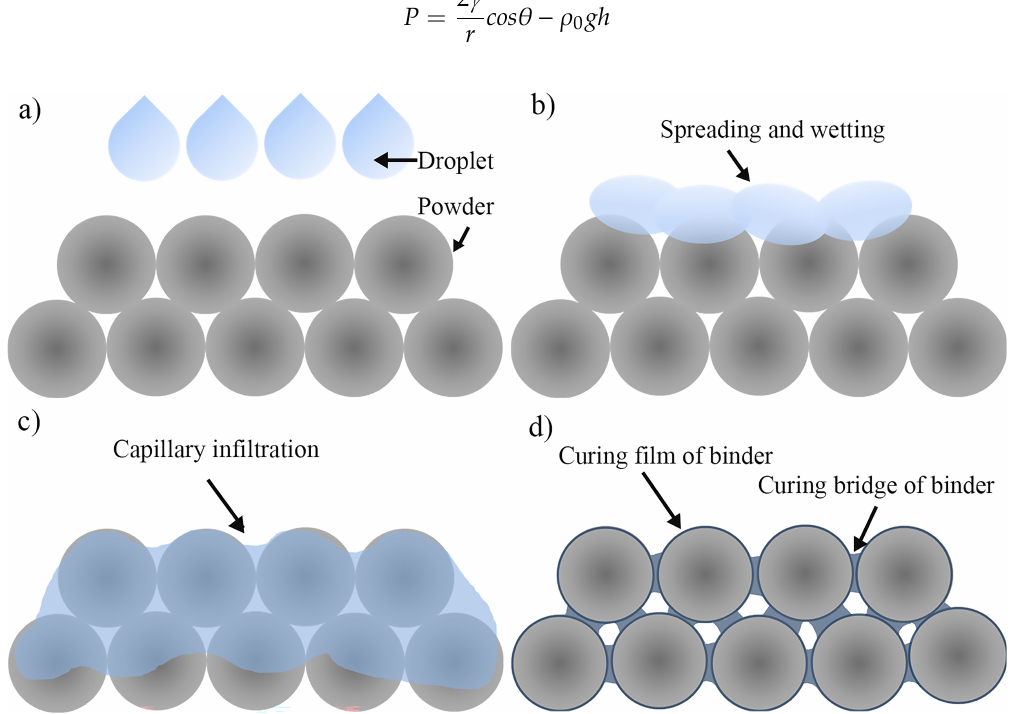
Figure 2. Principle of capillary infiltration forming of polymer binder, ( a ) binder droplets were selectively deposited into the powder bed, ( b ) binder solution spreads in the powder bed, ( c ) binder solution infiltrates in the powder bed, ( d ) curing film and bridge are formed after